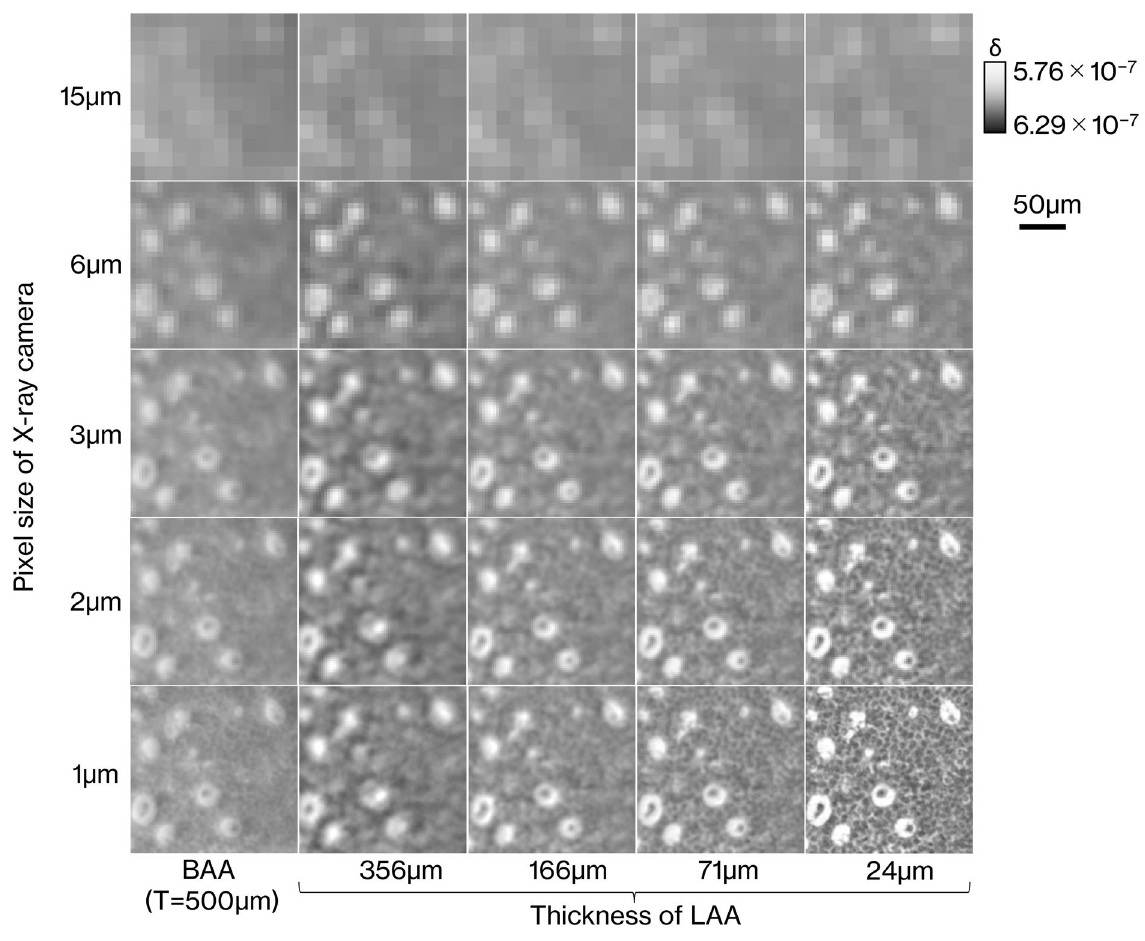
Figure 6. Reconstructed images of numerical phantoms converted from a breast cancer tissue specimen for evaluating the ability to delineate the cellular nuclear distribution. Each image is a magnified image of the area within the yellow square in Fig.